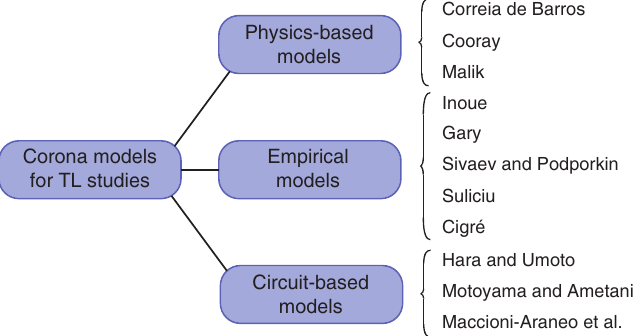
Figure 2. Corona models for TL